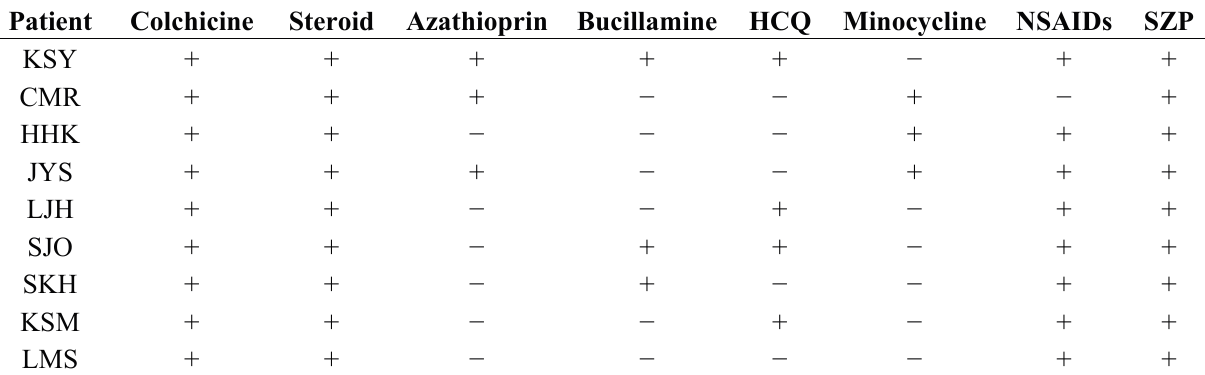
Table 2. Therapeutic histories of Behçet’s Disease